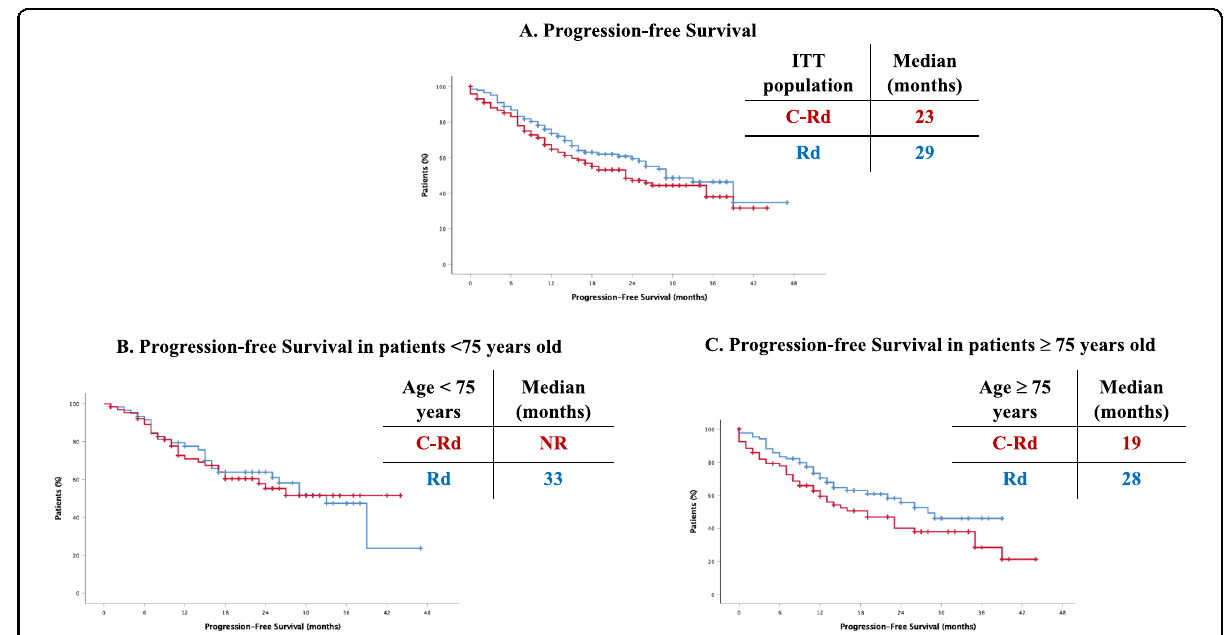
Fig. 1 Progression-free survival. A In the overall cohort, ( B ) In patients <75 years old, ( C ) In patients ≥ 75 years